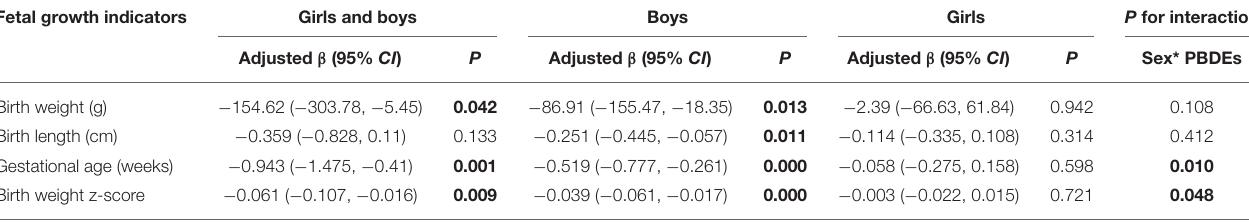
TABLE 5 | Associations between placental 6 PBDEs concentration (low vs. high) and other fetal growth indicators. Fetal growth